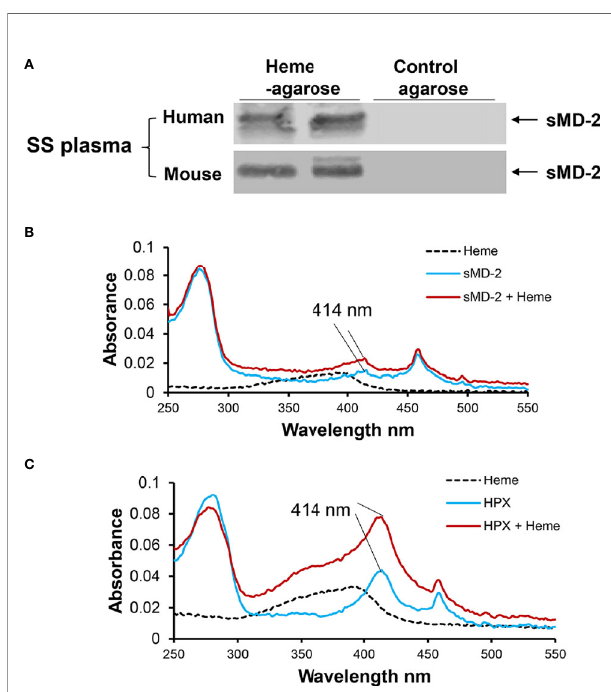
FIGURE 4 | sMD-2 binds heme. (A) To determine the physical interaction between sMD-2 and heme, human SS plasma was incubated overnight at 4°C with heme-agarose or control agarose beads. The pelleted beads were washed with PBS 6 times. The pull-down proteins bound to the beads were then run on an SDS-PAGE Western bot using anti-MD-2 IgG as the primary detection antibody. Six SS plasmas were examined in independent experiments with similar results. Representative Western blots of 2 SS human and mouse plasmas are shown. (B, C) UV/Vis absorption spectra (250 - 550 nm) of recombinant (B) sMD-2 and (C) hemopexin (HPX, positive control), with and without added heme. Absorbance spectra show scans of heme alone (black dashed line), recombinant protein alone (blue line) and recombinant protein plus heme (red line). The Soret peak at 414 nm, indicative of heme binding, increases in the presence of added heme (red) for sMD-2 and HPX. In the absence of added heme, both recombinant proteins appear to have some bound heme (blue line) as shown by the Soret peak at 414 nm. The UV/Vis scans (B, C) are representative of 3 independent